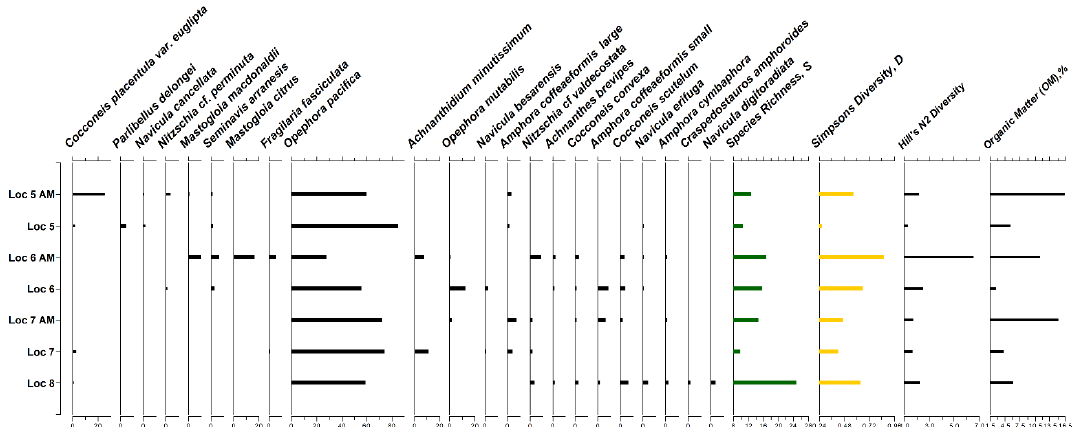
Figure 3. Relative abundance of the diatom species together with diatom species richness (S) and Simpson’s diversity (D), Hills diversity N2 and % Organic Matter (OM) in the surface sediments of the mangrove forest in the Khor al Beida, UAE. Only taxa, occurring at 2% of relative abundance are shown. AM is algal mat. Diatom taxa are ordered by their weighted averaging (WA) scores in C2 [30].